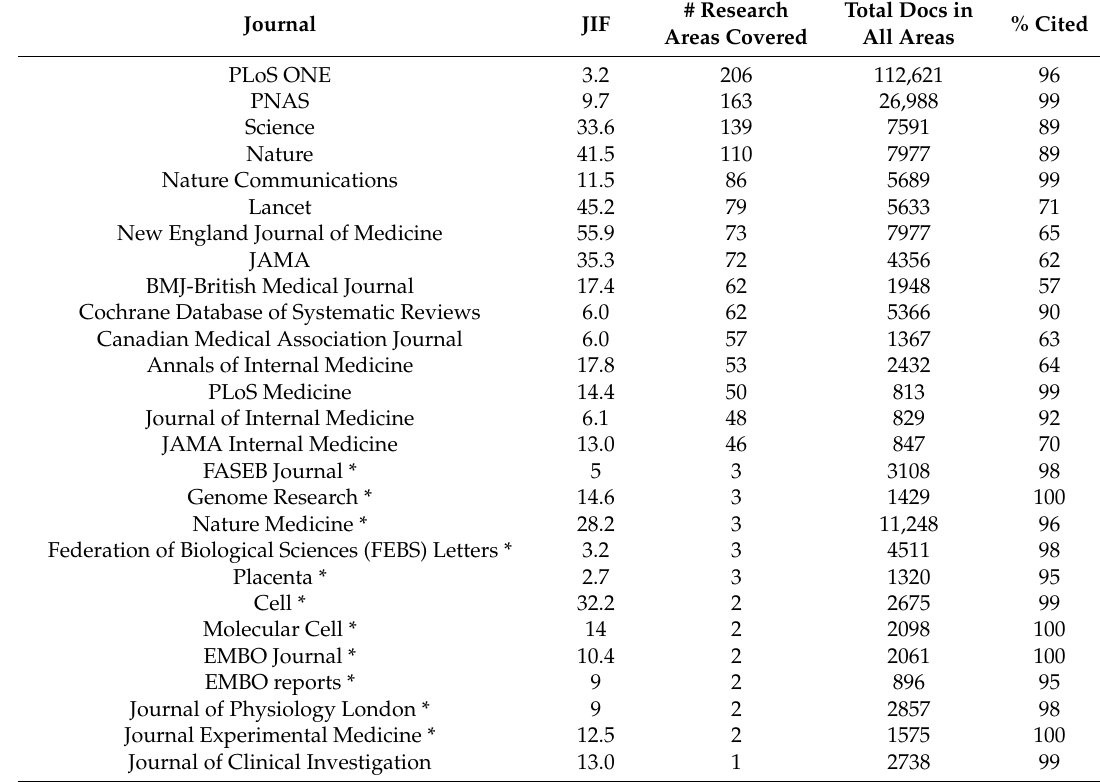
Table 2. Multidisciplinary Journals.